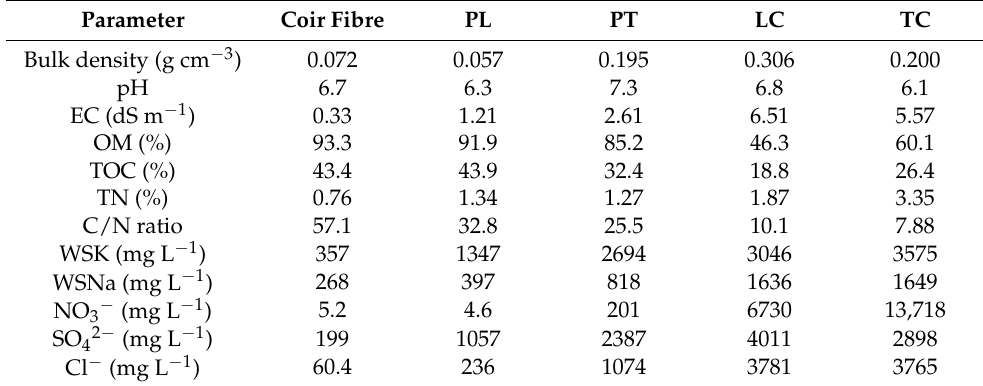
Table 1. Physico-chemical and chemical properties of the ingredients used in the growing media. Parameter Coir